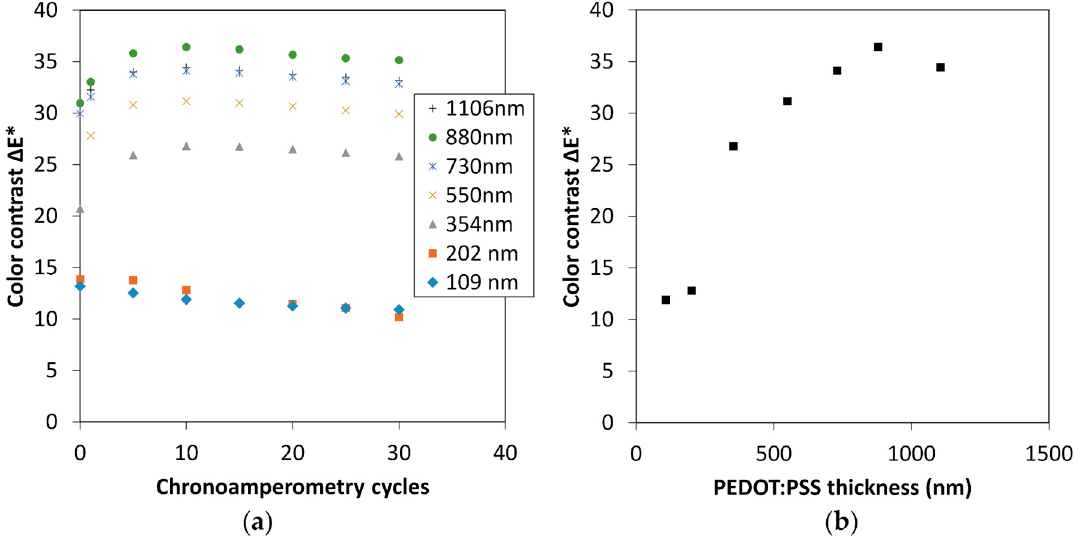
Figure 3. ( a ) Color contrast ∆ E ∗ as a function of the chronoamperometry cycles of electrochromic displays built from PEDOT:PSS thin films with varying thickness from 109 nm to 1106 nm, ( b ) color contrast as a function of PEDOT:PSS thickness, after 10 cycles of chronoamperometry. For both graphs, applied potentials were +1.6 V for 20 s, and 1.6 V for 20 s.